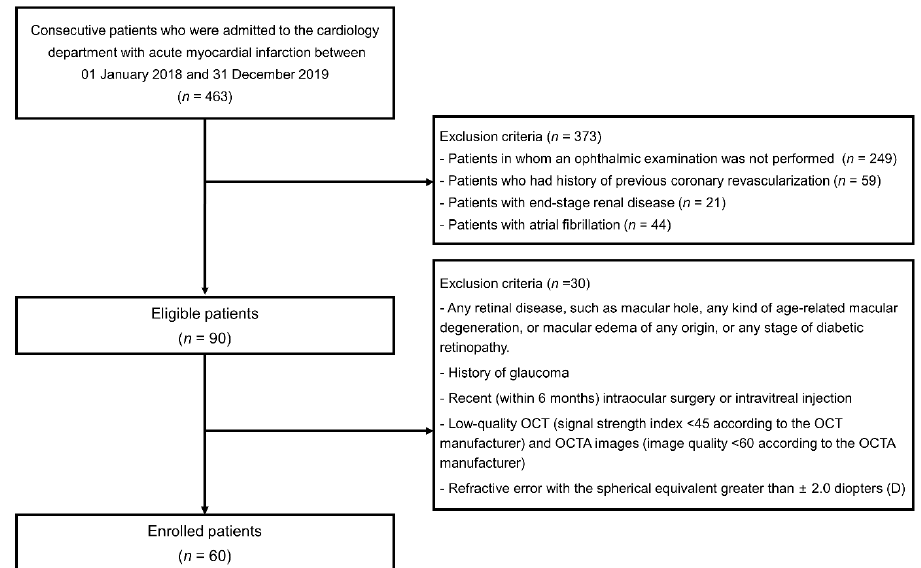
Figure 1. Flow chart of enrolled patients and exclusion.